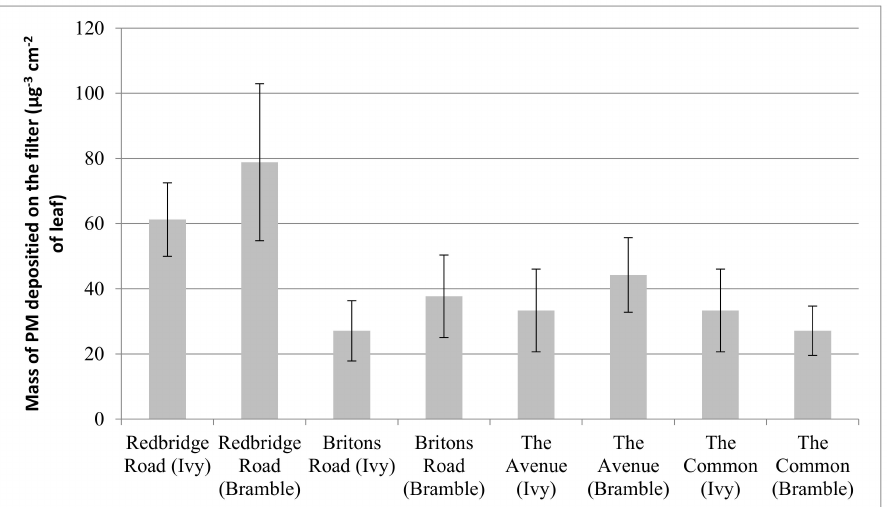
Figure 4. Average PM mass ( < 100 µ m) washed from leaf surfaces, per unit area for each site. Standard error displays large variation in PM mass at each site. Site 1: Redbridge road; Site 2: Brinton’s Road, Site 3: The Avenue; Site 4: Southampton